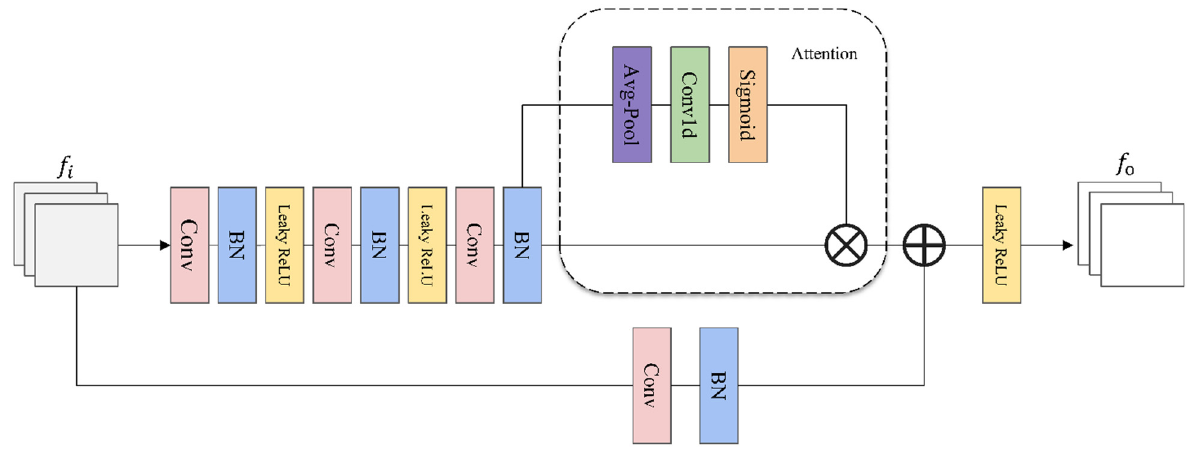
Figure 3. The details of the improved ResNet50 using ECA